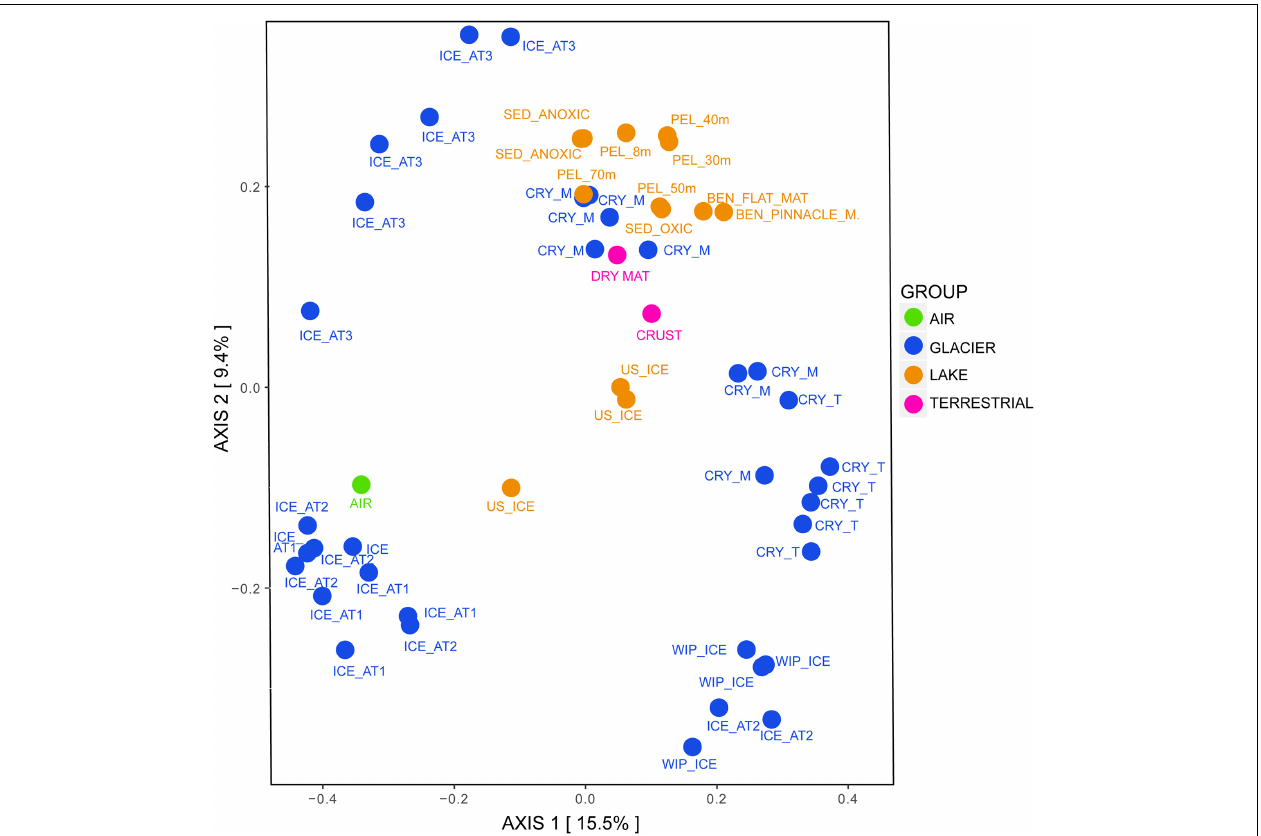
FIGURE 6 | Bacterial beta diversity in the Untersee Oasis displayed as PCoA plot using Bray-Curtis distance matrix. The habitats “Air,” “Anuchin” (glacier), “Lake” (Untersee), and “Terrestrial” are color coded. CRY_M, Cryoconite holes from the medial moraine; CRY_T, Cryoconite holes from the glacier terminus; SED, Sediment; PEL, Pelagic; BEN, Benthic. Further differentiation is described in the Section “Materials and Methods.”